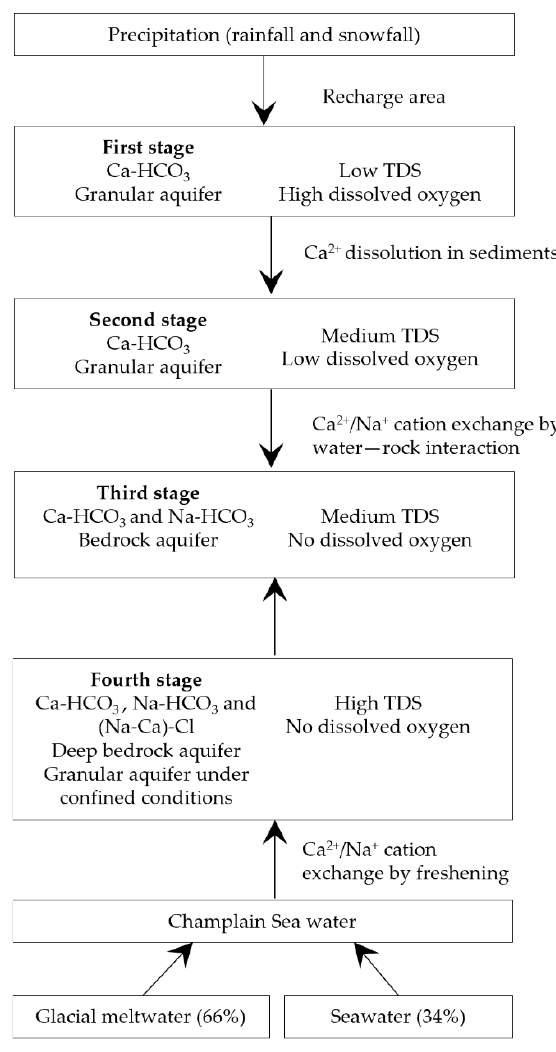
Figure 10. A regional hydrogeochemical conceptual model of groundwater evolution and ground- water characteristics, including water type, aquifer type, TDS, dissolved oxygen, and the dominant geochemical processes .